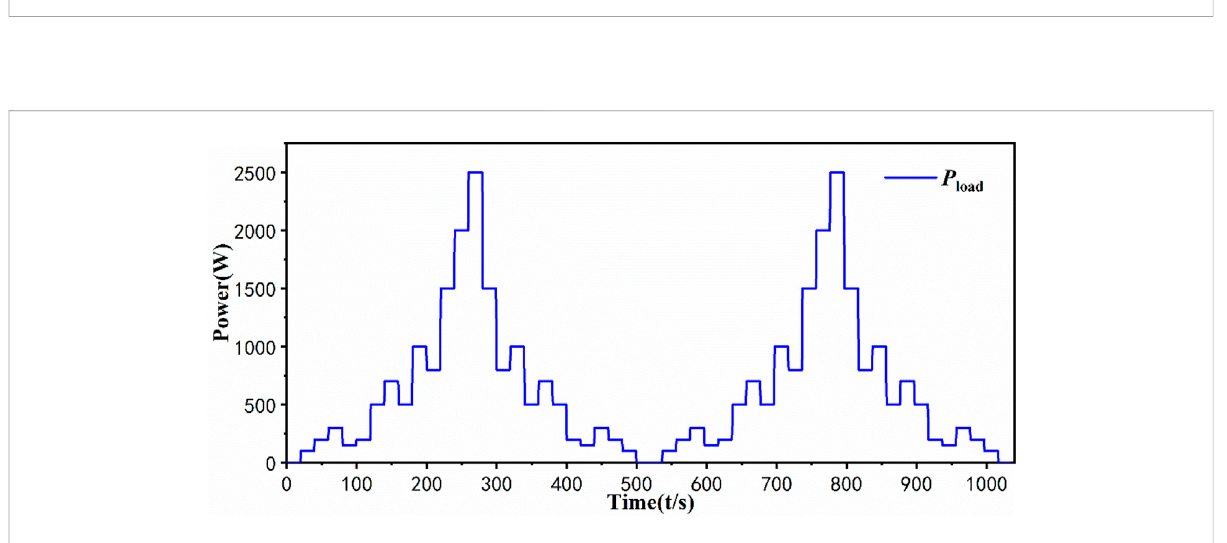
FIGURE 7 Demand power of the whole